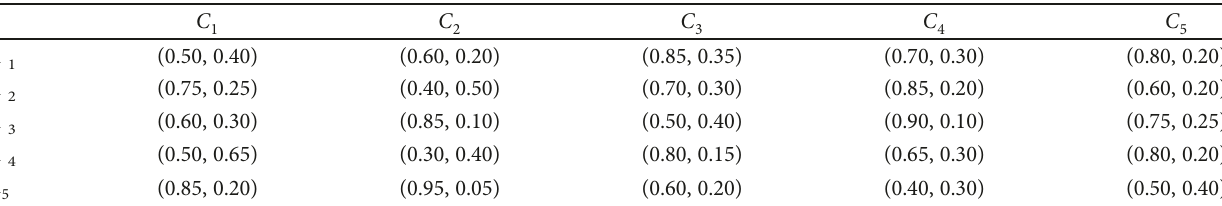
Table 2: Pythagorean fuzzy decision matrix D 2 .